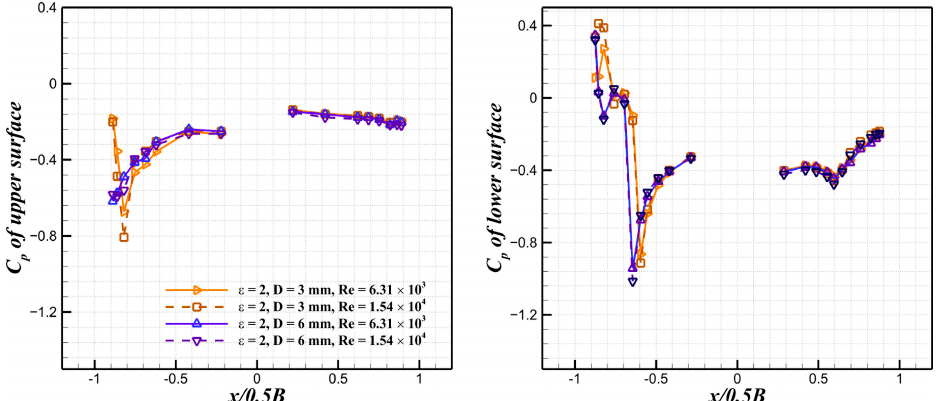
Figure 12. Comparisons of the time-averaged surface pressure distribution of the twin-box girder with circular cylinder interference and bare deck.